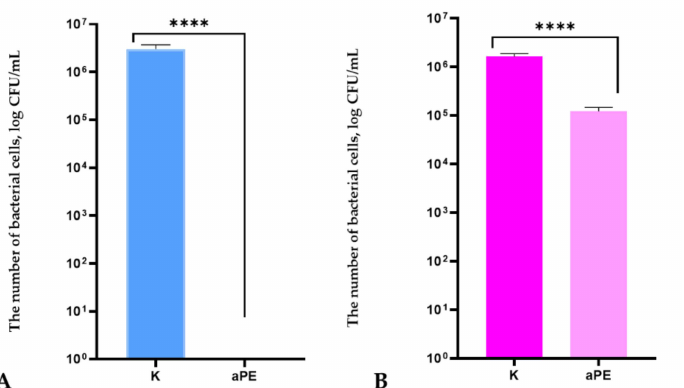
Figure 1. The influence of active polyethylene film (aPE) on Gram-positive bacteria growth A : S . aureus ; B : B. subtilis . K—PE film; aPE—PE film containing a mixture of CO 2 extracts of raspberry